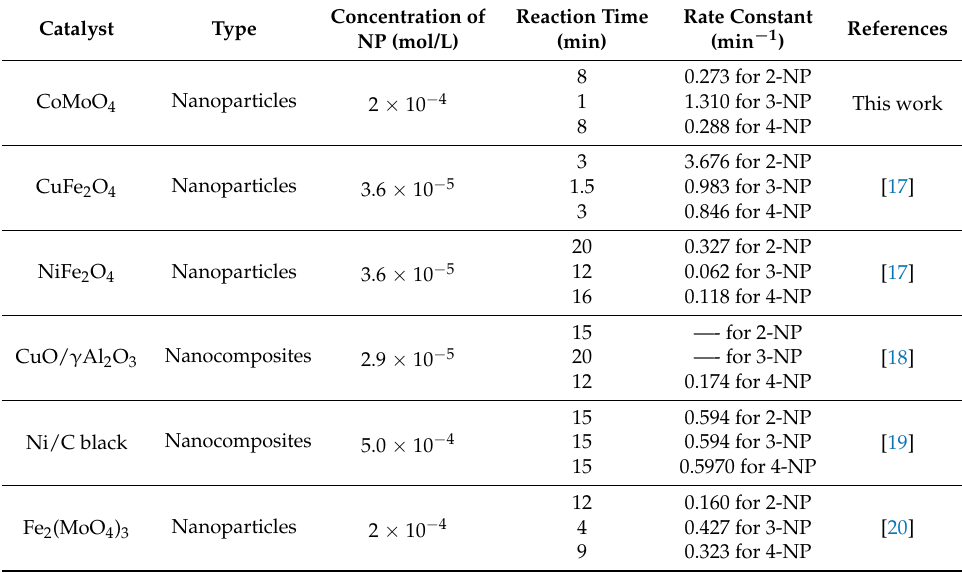
Figure 8. Recycled catalyst against reduction time in the reduction of 3-NP with NaBH 4 catalyzed with β -CoMoO 4 nanoparticles. Table 1. Pseudo-first order rate constants for the reduction of 2-NP, 3-NP, and 4-NP by CoMoO 4 with other nanocatalysts reported in the literature.